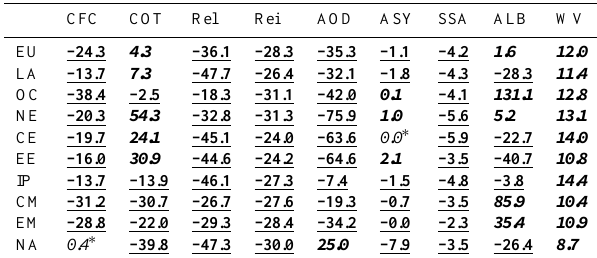
Table 3. Annual normalized mean bias (NMB) of RegCM4–CM SAF CFC, COT, Rel and Rei; RegCM4–MACv1 ASY and SSA; RegCM4–CERES ALB; and RegCM4–ERA-Interim WV.